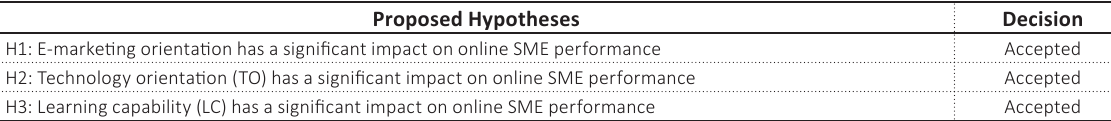
Table 4. Summary of hypothesis